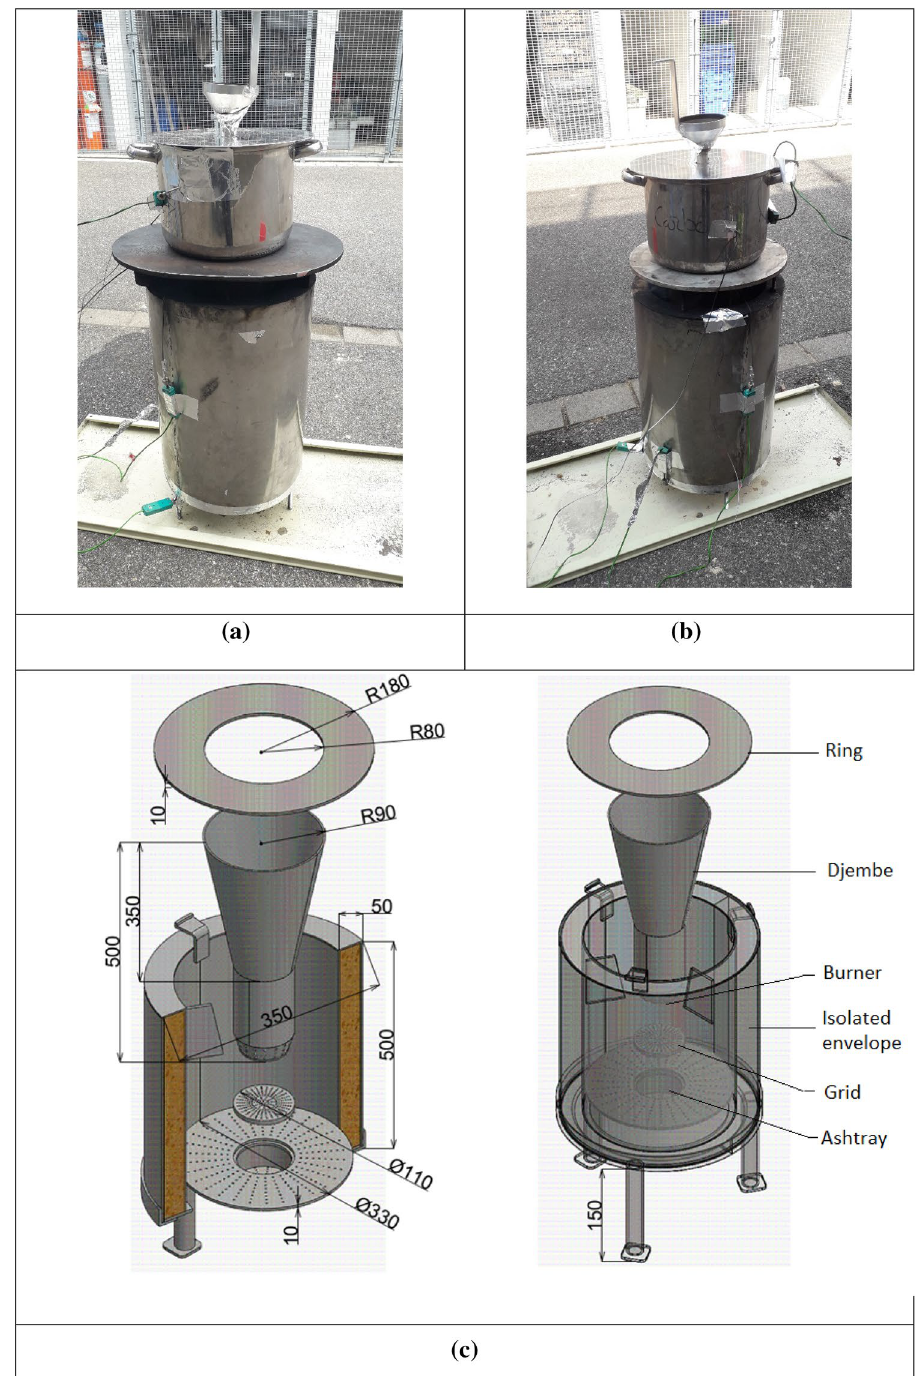
Fig. 1 Photographs of the improved cookstove with the plate (a) or ring (b) configura- tions, and 3D scheme (c) of the improved pellet cookstove with the thick